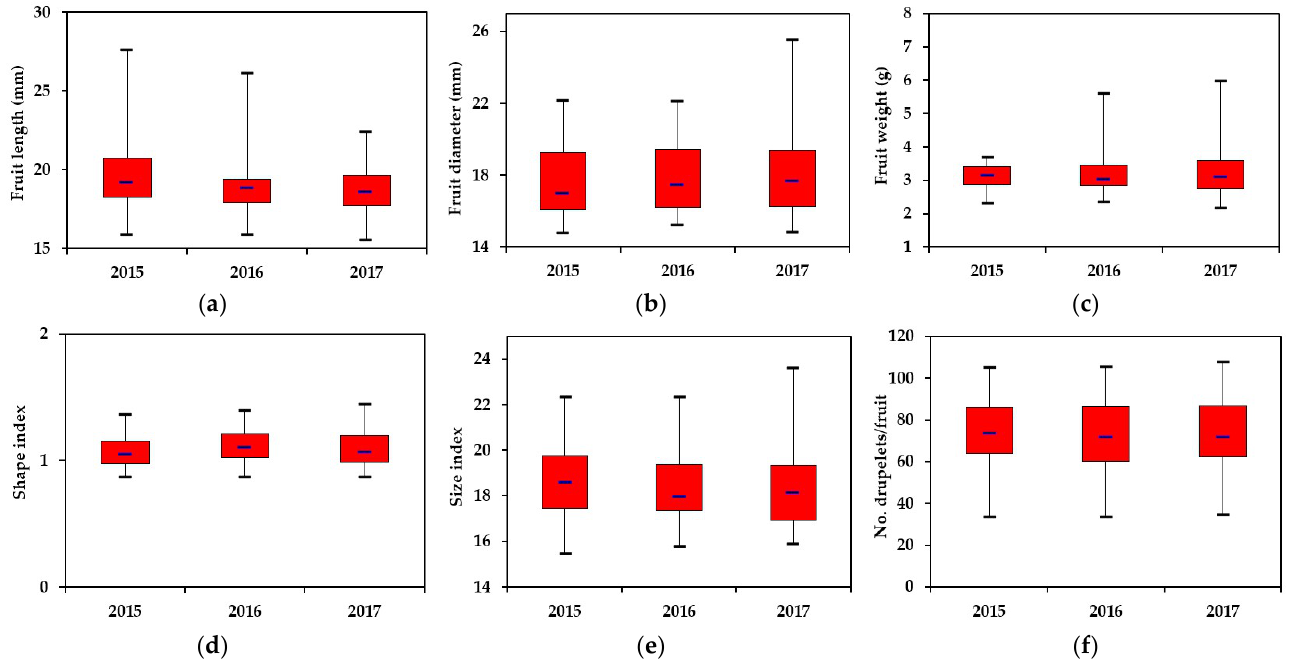
Figure 1. Boxplots of the main morphological features of the fruits of 24 raspberry genotypes over three consecutive years (2015, 2016, and 2017) starting from the second year after the establishment of the plantation: ( a ) fruit length (mm); ( b ) fruit diameter (mm); ( c ) fruit weight (g); ( d ) shape index; ( e ) size index; ( f ) the number of drupelets/fruit (berry). Each boxplot represents minimum, lower quartile, median, upper quartile, and maximum values.